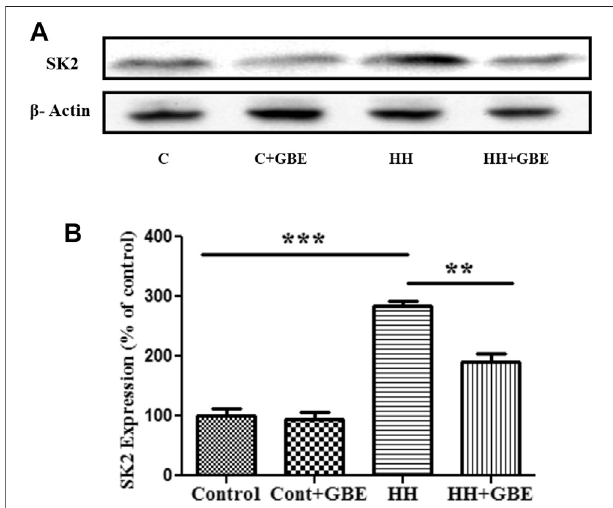
FIGURE 6 | GBE reduces expression of the SK2 channel. Immunoblot indicates expression of the SK2 channel (A) . The optical density analysis of SK2 expression using ImageJ software showed that, after 14 days of HH exposure,SK2expressionincreased,whileGBEsigni fi cantlyreducedits expression (B) .One-wayANOVAwiththeBonferronitestwasusedtoanalyze the data. Data are represented as mean ± SEM. ** p < 0.01 and *** p < 0.001.